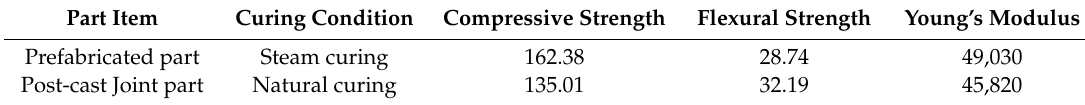
Table 4. Mechanical properties of UHPC (MPa).